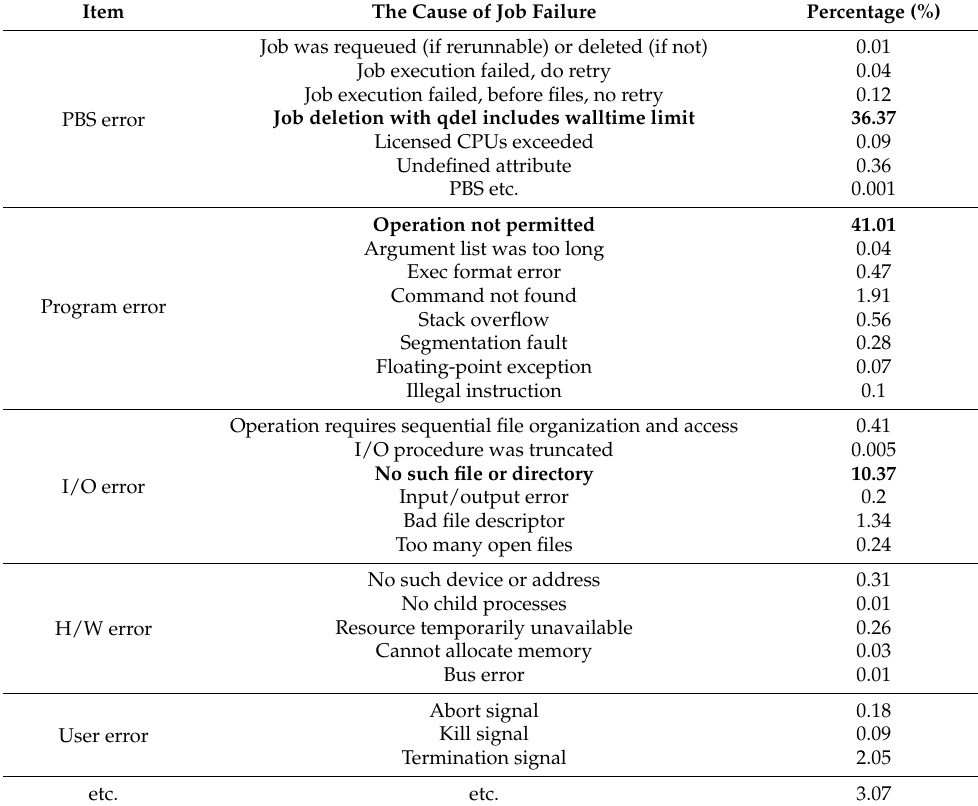
Table 2. Detailed description of the causes of job